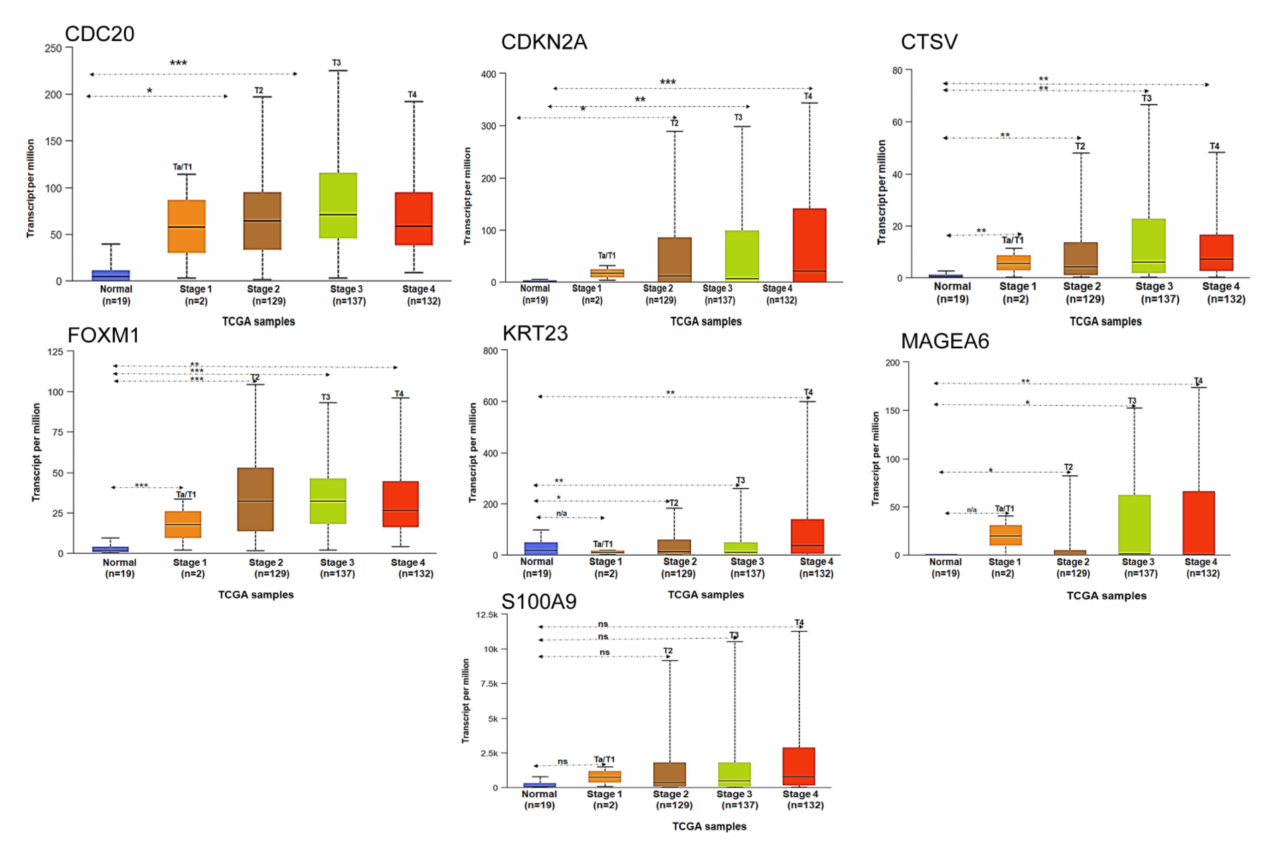
Figure 6. Expression of seven gene subset in bladder cancer based on sample types. The expression of CDC20, CDKN2A, CTSV, FOXM1, KRT23, MAGEA6, and S100A9 based on tumor stage. The figures were generated using ULCAN database. * p < 0.05, ** p < 0.001 and *** p < 0.0001 were considered statistically significant. ns,